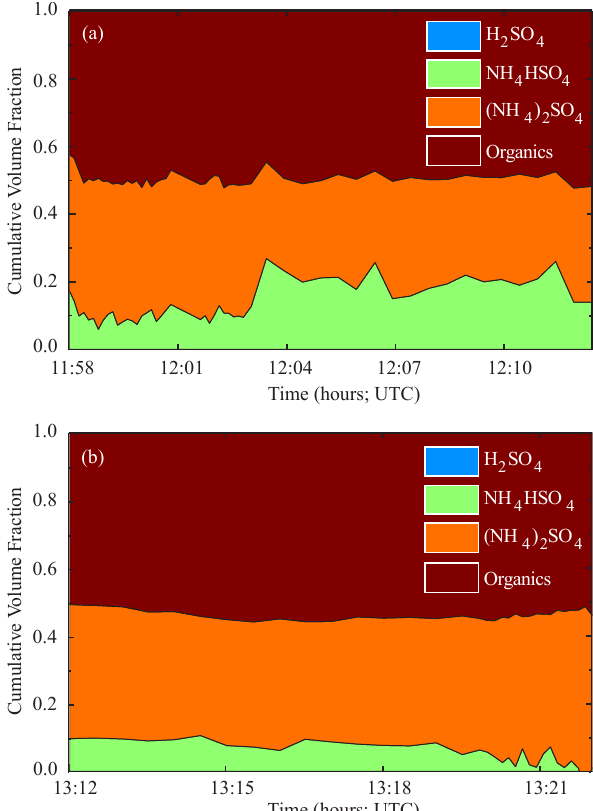
Fig. 5. Cumulative volume fractions of the chemical species com- prising the particles in the atmosphere over the ground station on Lemnos Island during the flights performed on 1 September (flight b637) (a) and on 4 September (flight b641) (b) . The volume frac- tions are estimated by the ion pairing algorithm and the chemical composition measurements from the airborne